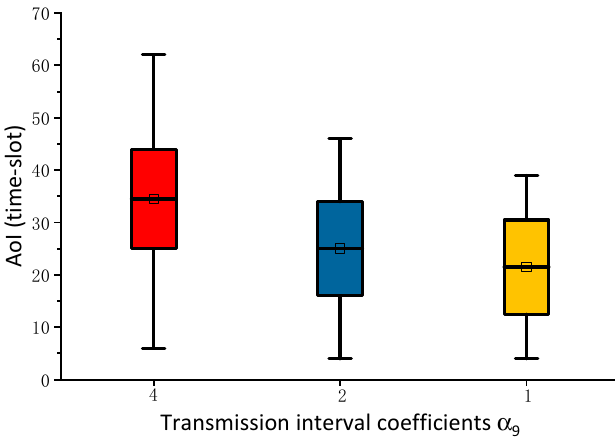
Figure 7. Boxplot of AoI for node #9 with different TIC α 9 .